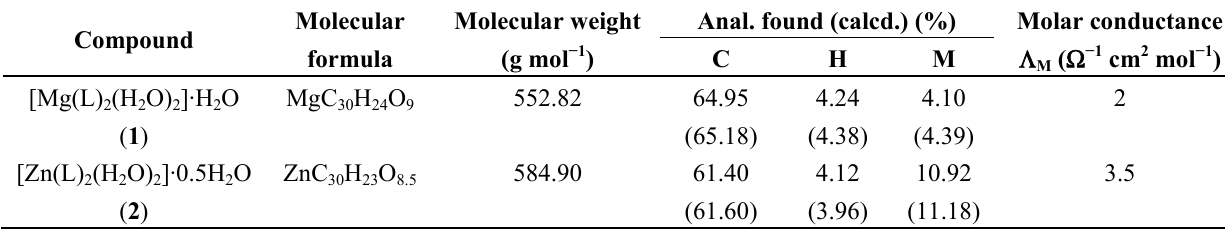
Table 2. Analytical and molar conductance data for the complexes.